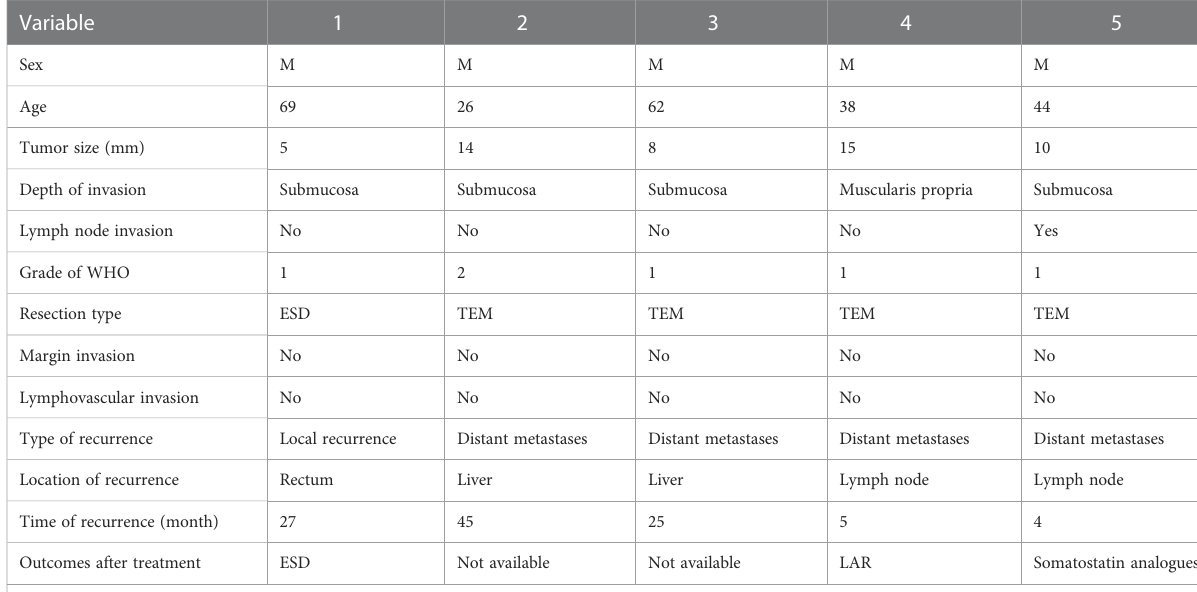
TABLE 5 Characteristics of tumors for patients with recurrent rectal